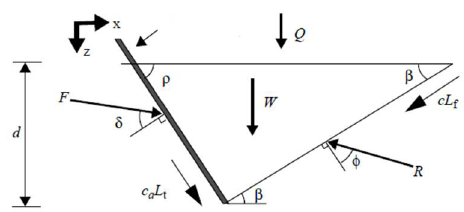
Figure 21. Excavation force (given by